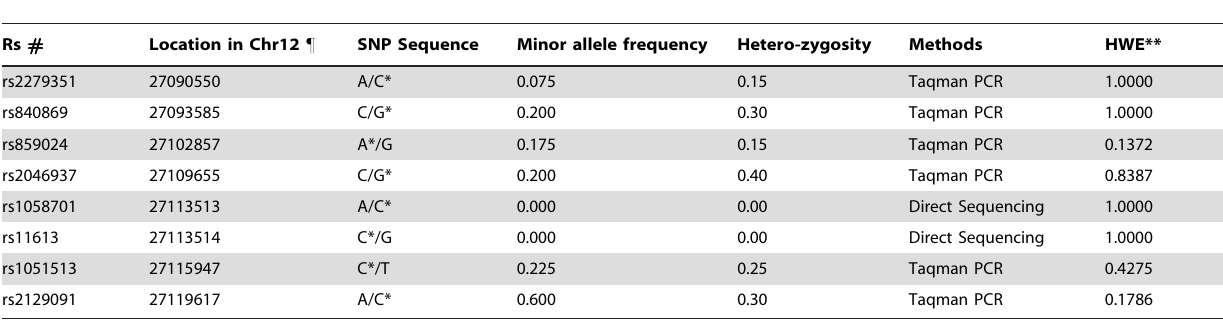
Table 1. Frequencies of FGFR1OP2/wit3.0 SNPs in edentulous subjects (n=20).